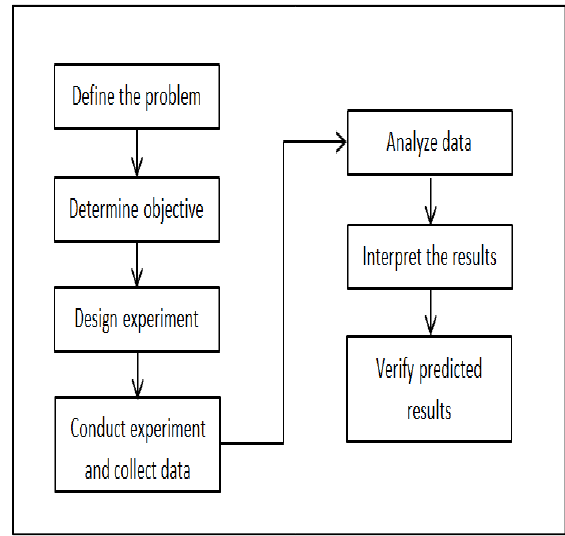
Fig. 7. define the research problem and their